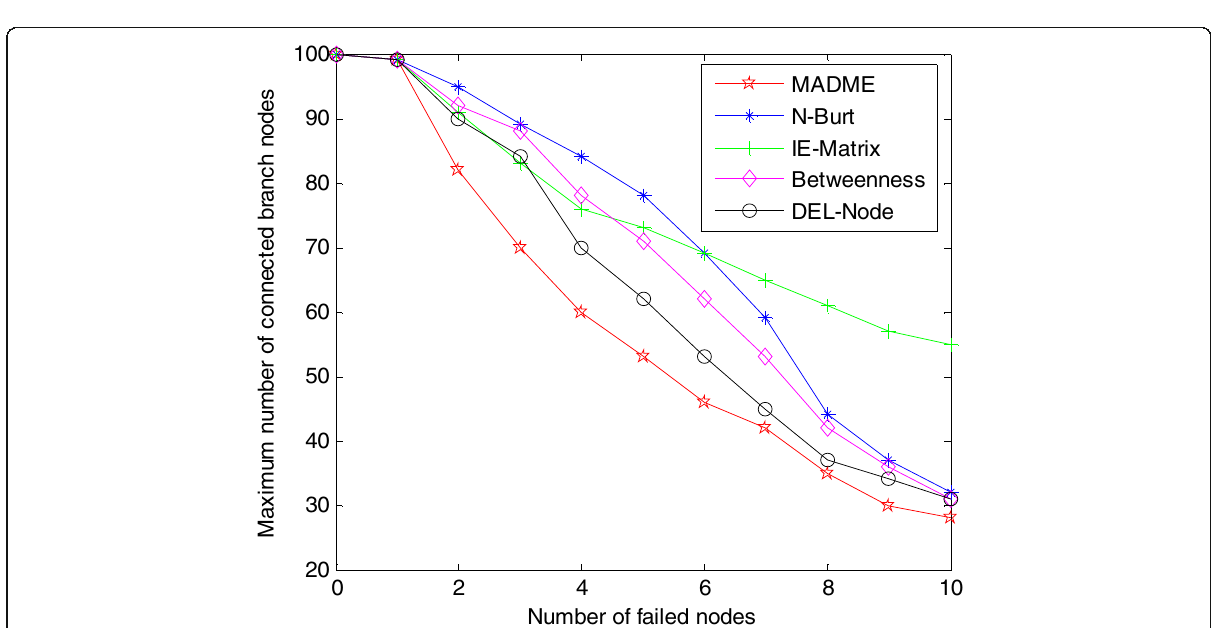
Fig. 6 The maximum connected branch after removing the key nodes. The effect of attack on the network robustness under the five methods, such as the MADME, N-Burt, IE-Matrix, betweenness, and DEL-Node methods, in which the top ten nodes with the highest importance evaluated by each method are removed in turn